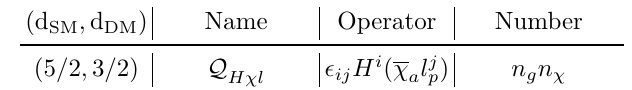
Table 13 . Dimension-four ∆ B = 0 , ∆ L = 1 operator in DSMEFT. The first column gives the dimensions of the SM and DM part of the operator, and the fourth column is the number of operators.